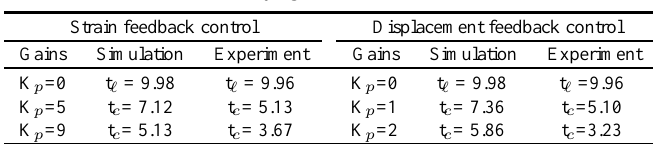
Fig. 7. Results for the first natural frequency in Case 1, (a) experimental and (b) simulation. Table 5 Decaying times for Case